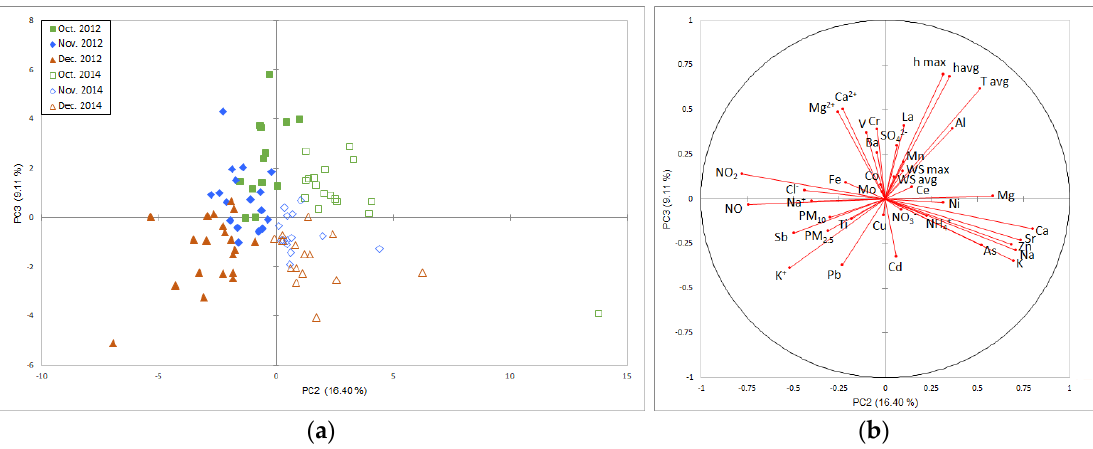
Figure 4. Principal component analysis (PC2 vs. PC3) for 2012 and 2014 samples: ( a ) score plot; ( b ) loading plot. WS avg = average wind speed; WS max = maximum wind speed; h avg = average mixing height; h max = maximum mixing height; T avg = average temperature.